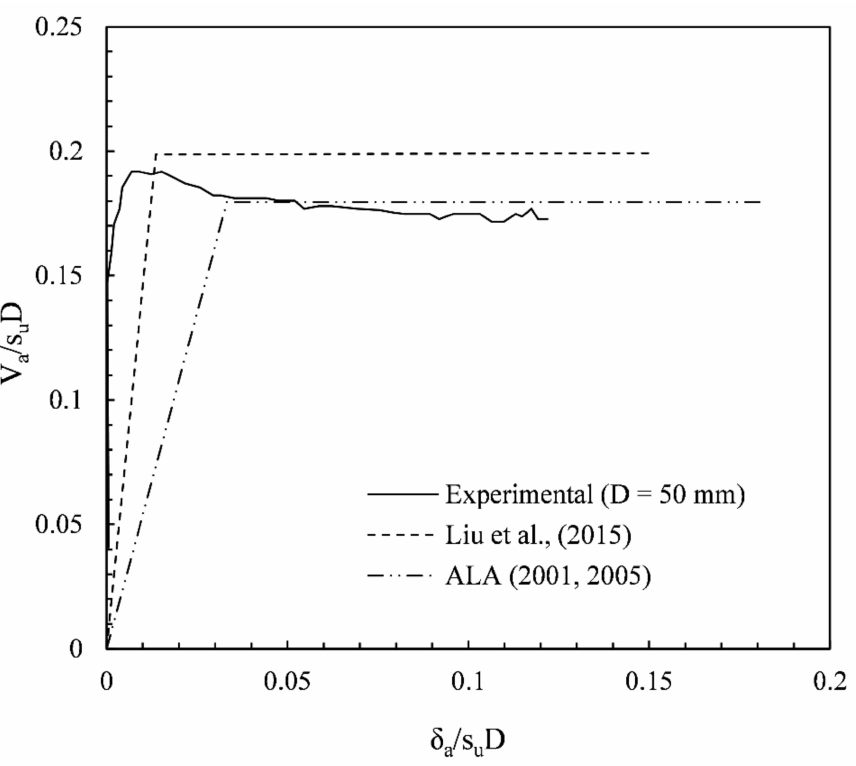
Figure 16. Comparison of axial resistance vs axial movement behaviour for different methods of analysis